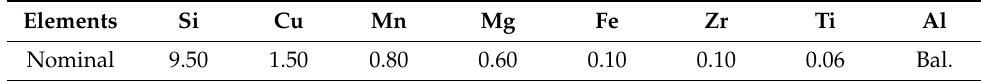
Table 1. Chemical composition of Al-9.5Si-1.5Cu-0.8Mn-0.6Mg alloy